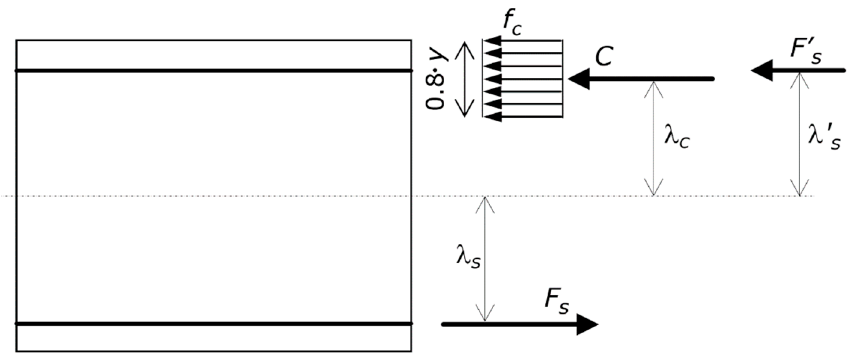
Figure 2. Reference structure. Ultimate stress profile on the cross-section. The figure shows the equivalent rectangular concrete compressive stress block f c , as well as its resultant internal force C together with its lever arm λ C , the resultant internal force F ’ s in the compression longitudinal steel reinforcement together with its lever arm λ ’ s , and the resultant internal force F s in the tension longitudinal steel reinforcement together with its lever arm λ s .